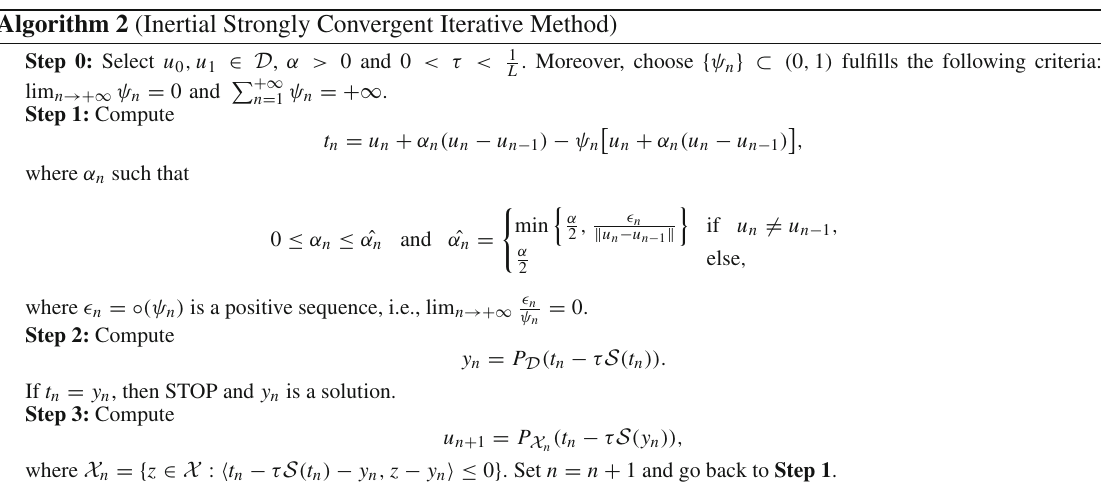
Algorithm 2 (Inertial Strongly Convergent Iterative